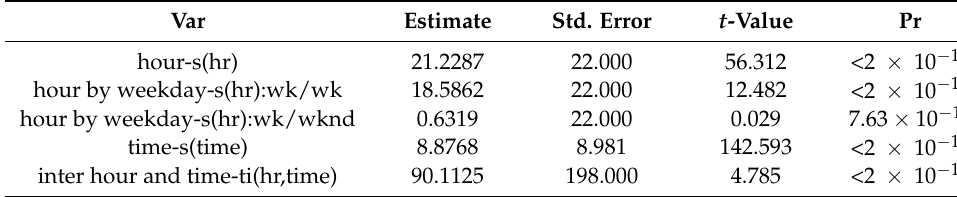
Table 3. Smooth terms/non-parametric coefficients for non-spatial GAM.